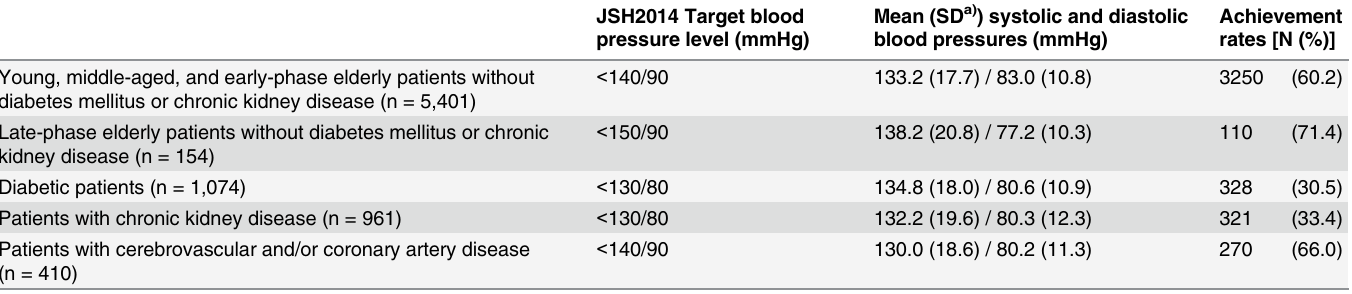
Table 2. Mean blood pressures and achievement rates for target blood pressure levels.